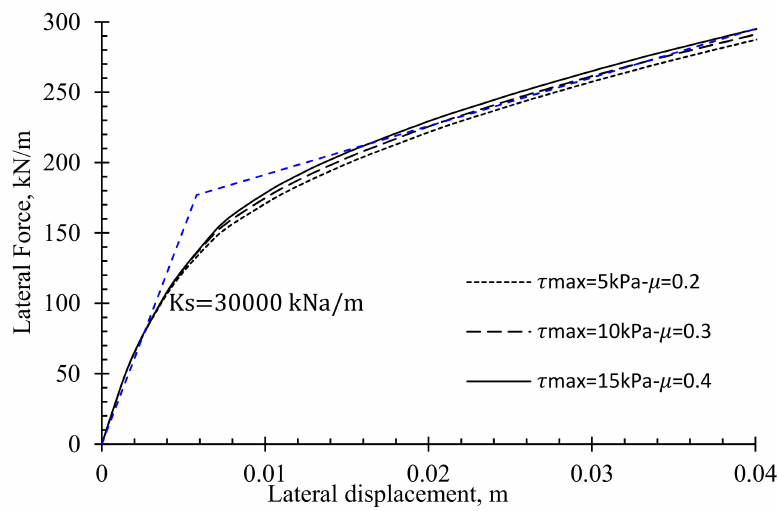
Figure 8. Lateral soil–pipe force–displacement curves for contact friction coefficients of 0.2, 0.3, and 0.4 in lateral sliding tests by 3D solid models.